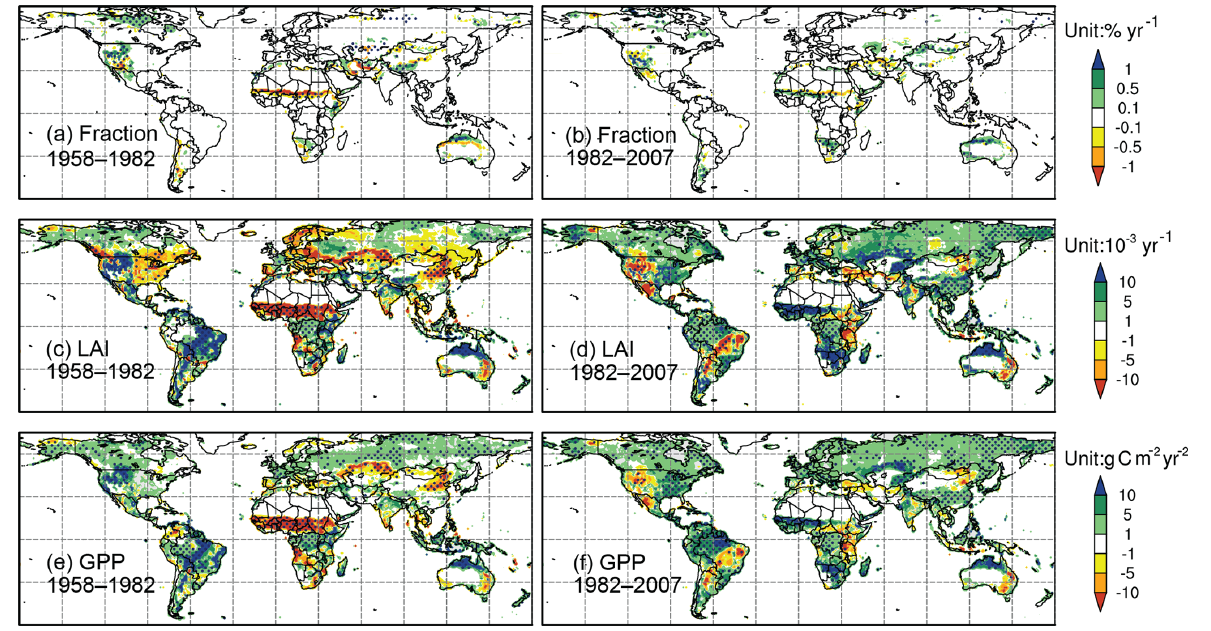
Figure 7. Trends (shaded) of (a, b) fractional coverage (units: %yr − 1 ), (c, d) LAI (units: 10 − 3 yr − 1 ), and (e, f) GPP (units: gCm − 2 yr − 2 ). Panels (a, c, e) are for 1958–1982 and (b, d, f) are for 1982–2007. The dots indicate the areas with significance level at P < 0 . 05 (Mann– Kendall